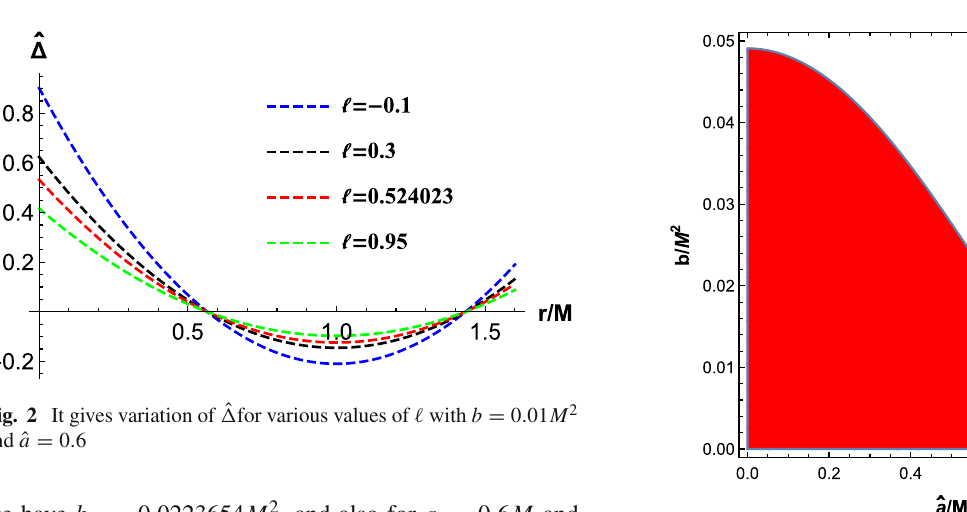
Fig. 1 The left one gives variation of ˆ (cid:5) for various values of ˆ a with b = 0 . 02 M 2 and (cid:2) = 0 . 3, and the right one gives variation for various values of b with ˆ a = 0 . 5 M and (cid:2) = 0 . 3